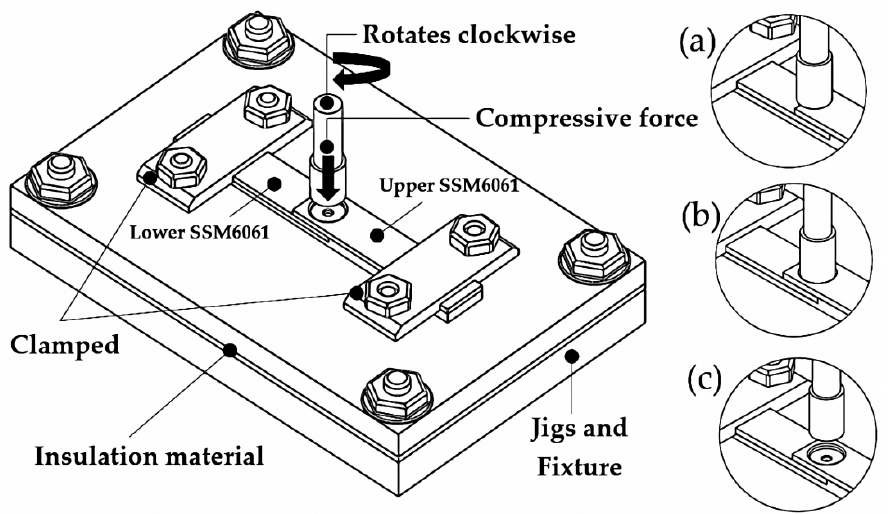
Figure 4. The schematic diagram steps of the FSSW process: ( a ) plunging, ( b ) stirring, and